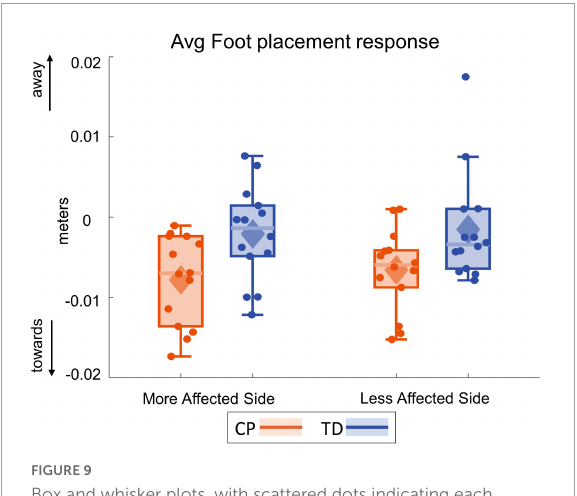
FIGURE9 Box and whisker plots, with scattered dots indicating each subject, for average foot placement response over first three post-perturbation steps for CP (orange) and TD (blue) groups on the more affected (left) and less affected (right)